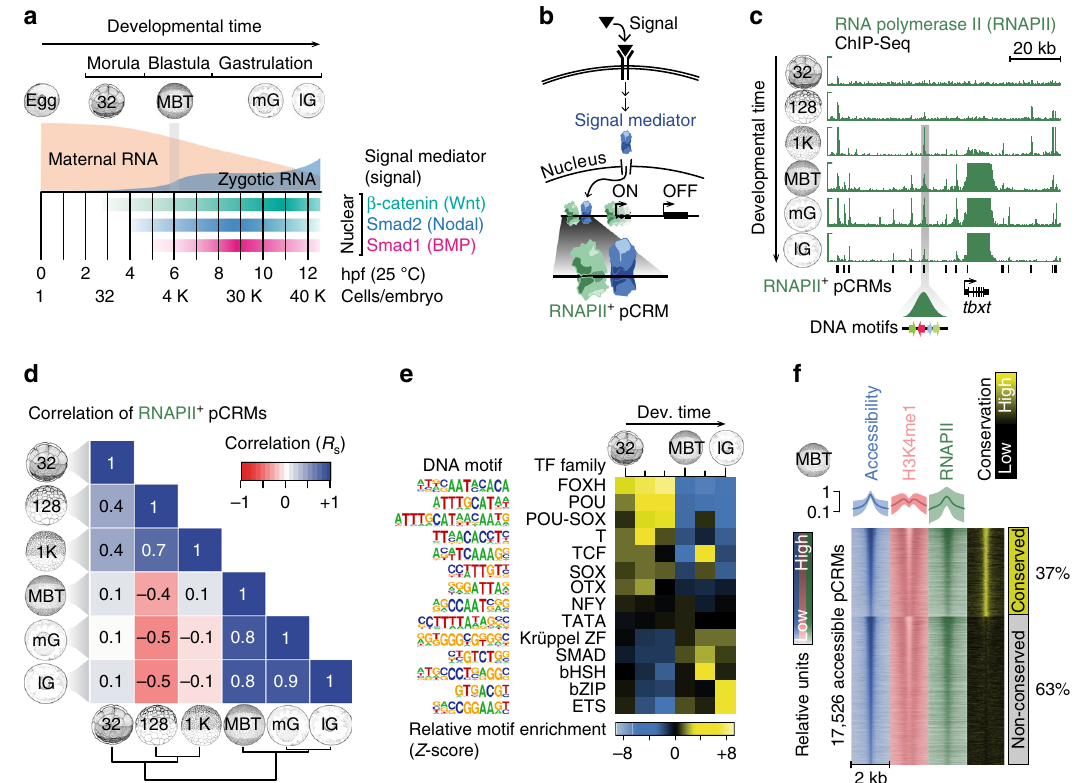
Fig. 1 Characterisation of pCRMs instructing ZGA. a Timeline (hpf, hours post-fertilisation, at 25 °C) of the maternal-to-zygotic transition and earliest signalling events (nuclear accumulation of Wnt, Nodal and Bmp signal mediators β -catenin, Smad2 and Smad1, respectively) during early X. tropicalis development up to the late gastrula embryo (12 hpf) with ∼ 40,000 (40 K) cells. b Signal transduction pathway causing signal mediators to enter the nucleus and engage with pCRMs (e.g., marked by RNAPII). c Snapshot of RNAPII recruitment to pCRMs of the zygotic gene locus tbxt from the 32-cell to the late gastrula stage. The underlying DNA sequence of RNAPII + pCRMs are used to discover enriched DNA motifs de novo (illustrated as coloured arrows for one RNAPII + pCRM). d Spearman correlations (R s ) of RNAPII binding levels across ∼ 27,000 pCRMs (Supplementary Data 2) between the indicated developmental stages. e Temporal enrichment (Z-score) of consensus DNA motifs known to be recognised by indicated TF families among RNAPII + pCRMs. f MBT-staged heat map of DNase-probed chromatin accessibility, RNAPII binding and H3K4me1 marking ( n = 2 biologically independent samples) across ∼ 17,500 pCRMs (Supplementary Data 3) grouped by sequence conservation levels (phastCons) and sorted by the statistical signi fi cance of pCRM accessibility. Abbreviations used for the developmental timeline: 32, 128 and 1 K, 32-, 128- and 1024-cell stage; MBT, mid-blastula transition;